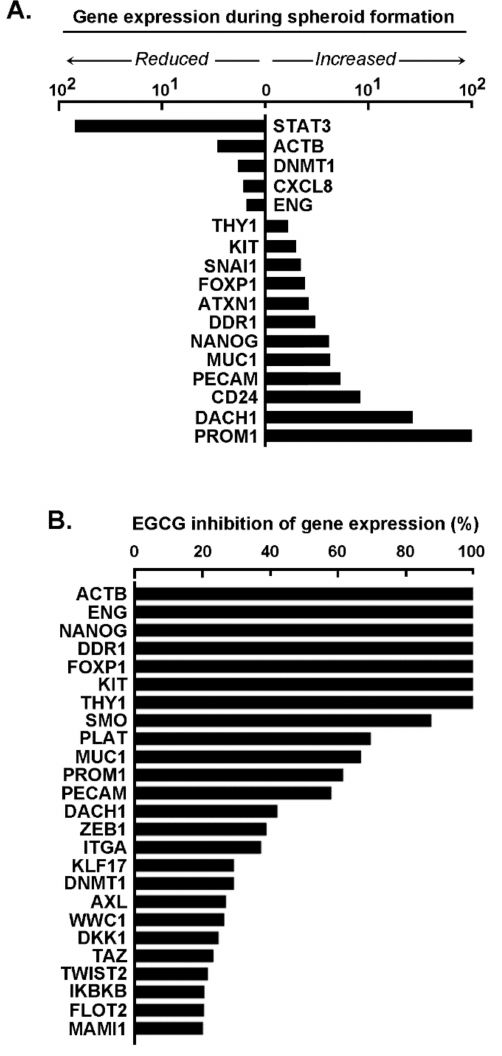
Figure 3. Transcriptional validation of the human ES-2 ovarian cancer stem cell phenotype and impact of EGCG. Tumorspheres were generated from adherent human ES-2 ovarian cancer cell monolayer cultures, as described in the Methods section, in the absence or presence of 30 µ M EGCG. Total RNA was extracted from either adherent monolayers (t = 0 h) or tumorspheres at 96 h, and RT-qPCR was performed using the RT2-Profiler gene array to assess the expression levels of cancer stem cell-associated genes. ( A ) Ratios of spheroid gene expression over adherent cells were performed and expressed on a logarithmic scale in untreated cells. ( B ) Ratios of tumorspheres grown in the presence of 30 µ M EGCG were calculated, and the extent of EGCG inhibition was presented as a